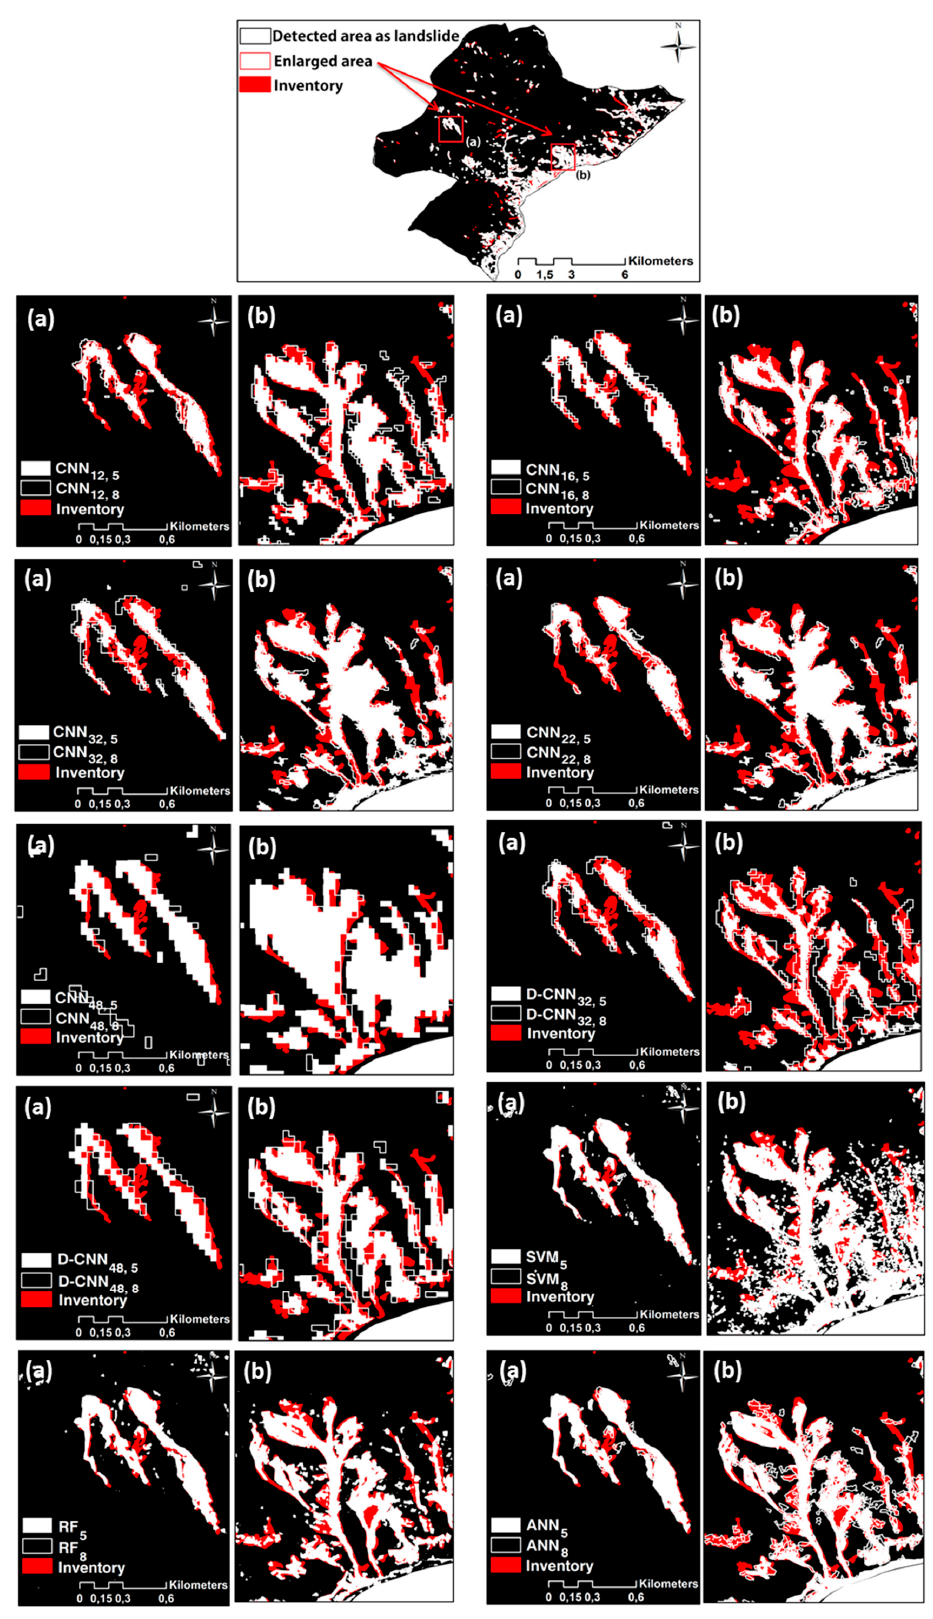
Figure 8. Enlarged maps of two different sub-areas from the test area. Landslide detection results are overlayed on the inventory data. In any CNN p,q and ML q the index of p corresponds to the size of the convolution input window, and q indicates the number of input layers that were used for